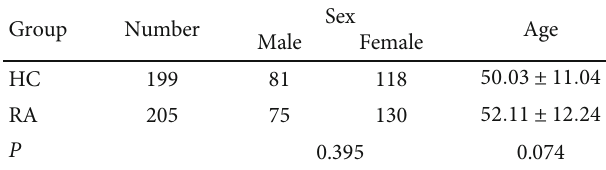
Table 1: Age and gender information of the enrolled